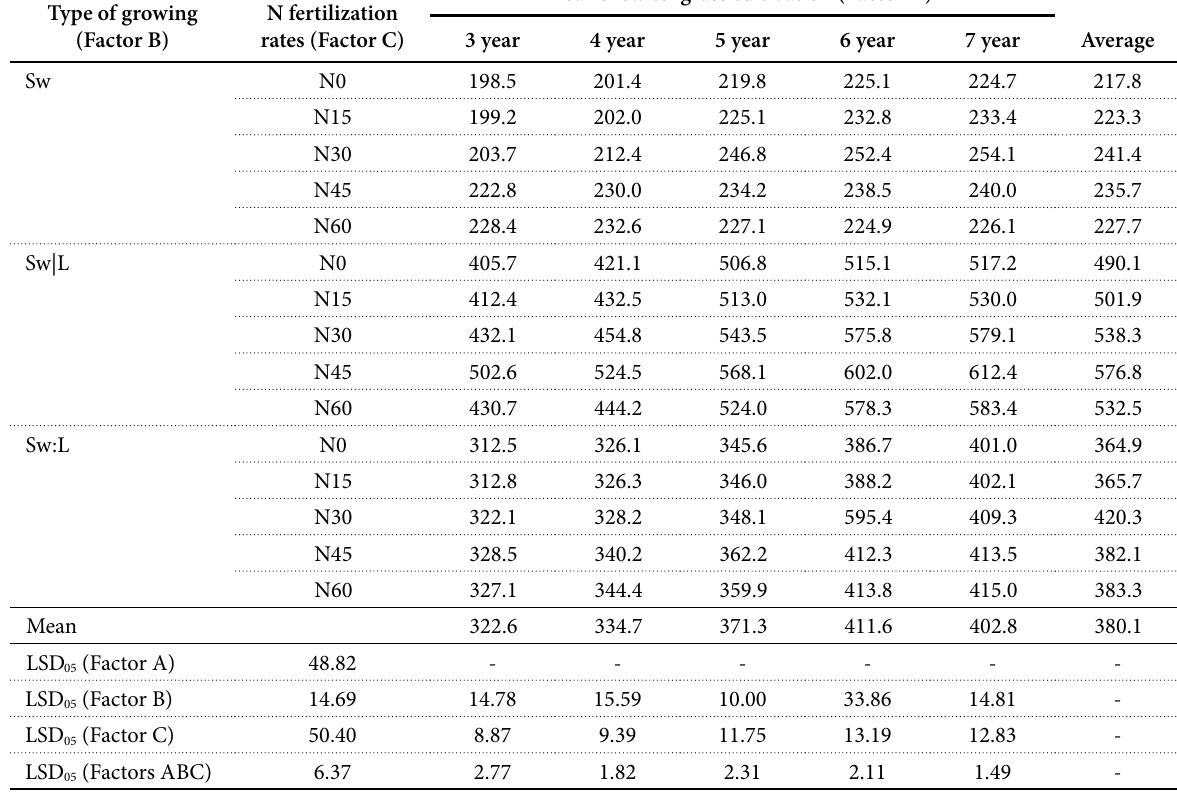
Tab. 2 Number of shoots of switchgrass plants per